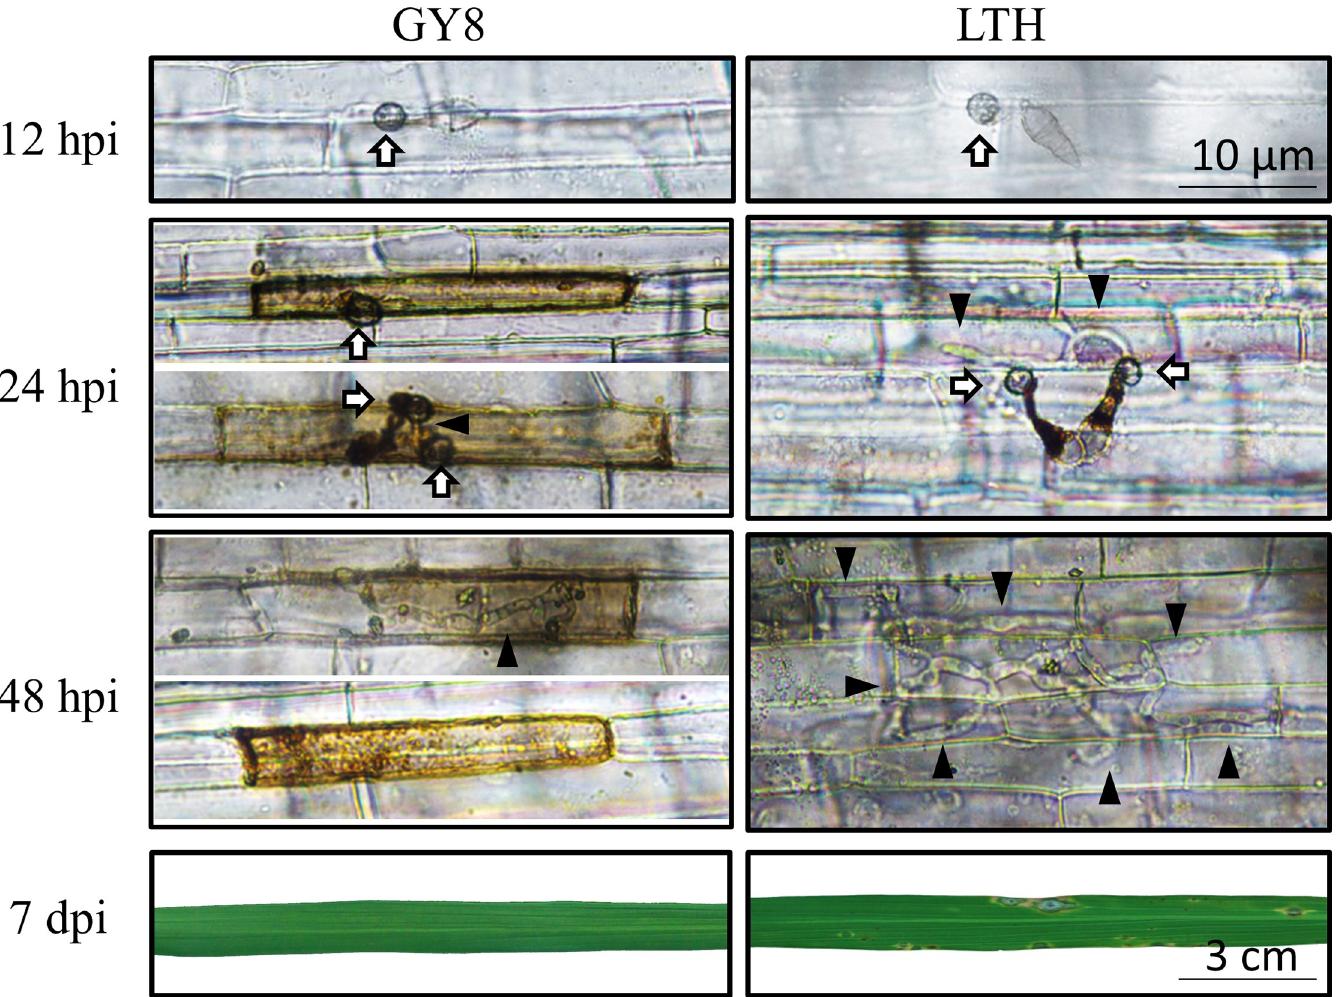
Fig 1. Development of Magnaporthe oryzae on rice leaf sheaths post-inoculation and the leaf at 7 d post-inoculation. The leaf sheaths of the durable resistant rice Gangyuan8 (GY8) and susceptible rice Lijiangxintuanheigu (LTH) were inoculated with spore suspensions of M . oryzae . The inoculated leaf sheaths were examined under a microscope at the time points of 12 hpi (hours post-inoculation), 24 hpi, and 48 hpi, and the leaves were photographed at 7 dpi (days post-inoculation). Arrows indicate infection structure appressorium, and the black triangle indicates invasive hyphae.